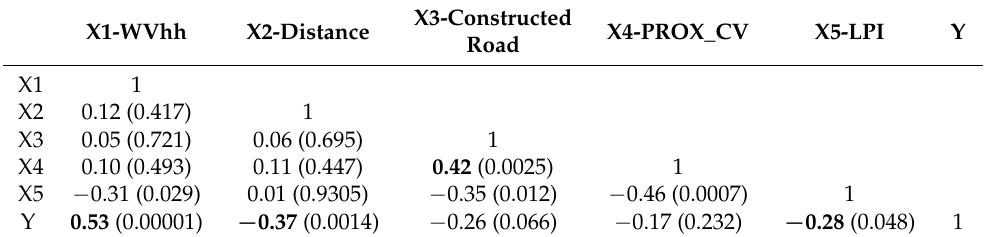
Table 2. Pearson correlation coefficients ( p -values) for inputs (X1 = WVhh (m 3 /ha), X2 = distance (km), X3 = constructed roads (km), X4 = PROX_CV (%), X5 = LPI (%)) and outputs Y = wood procurement cost transformed (CAD/m 3 ) among selected DEA variables (see Table 1 for